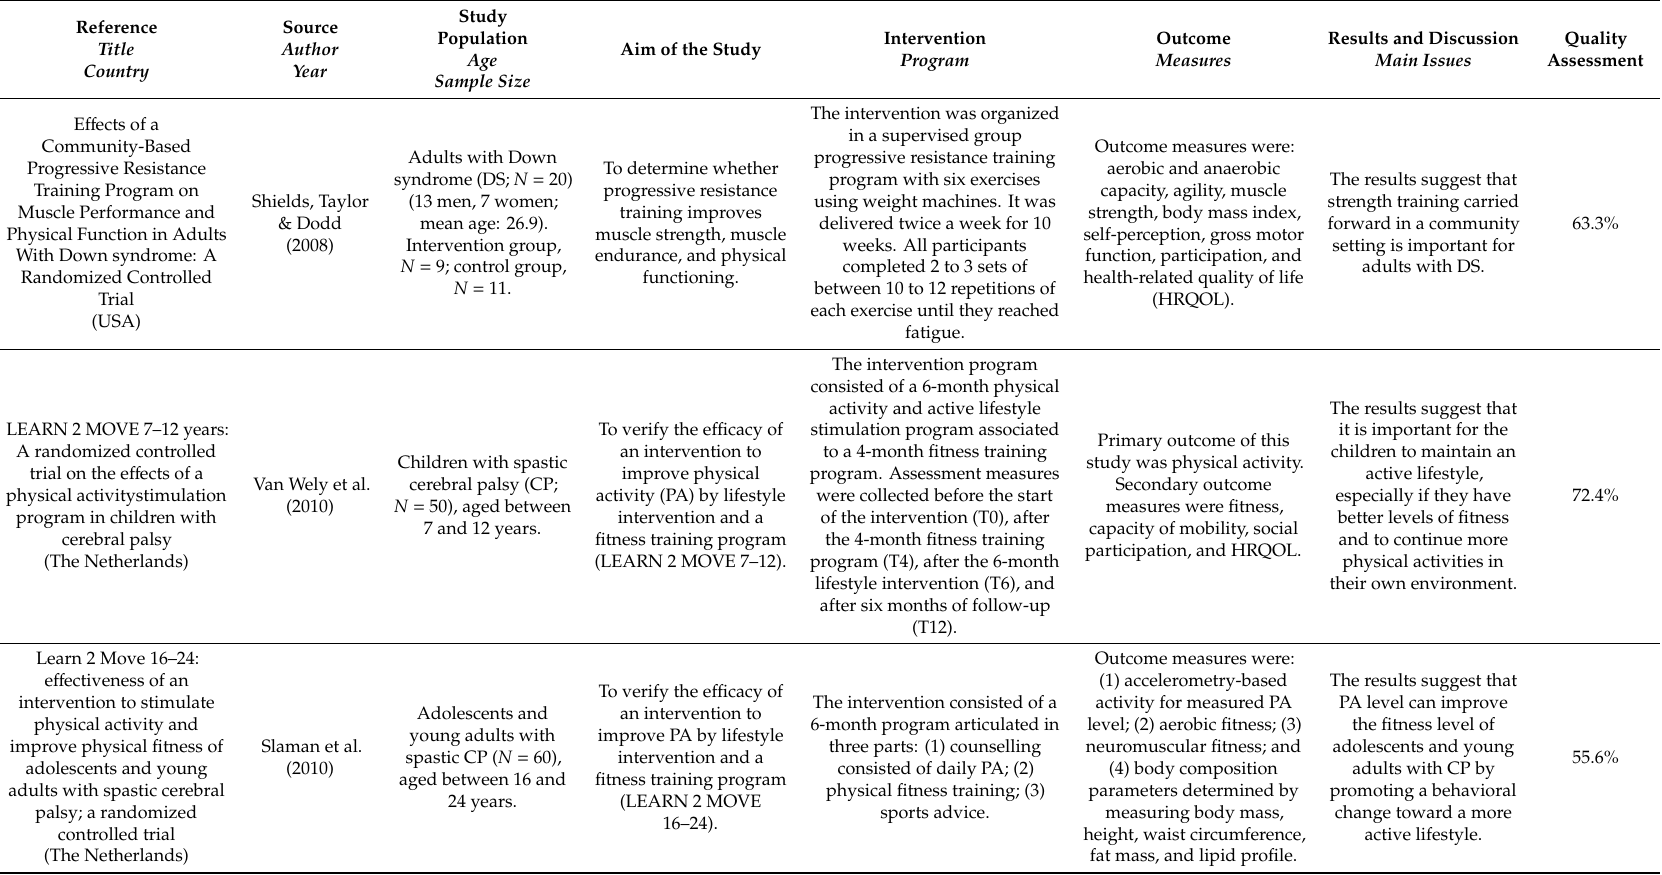
Table 1. Randomized controlled trial study (RCTS): papers analyzed in order of publication